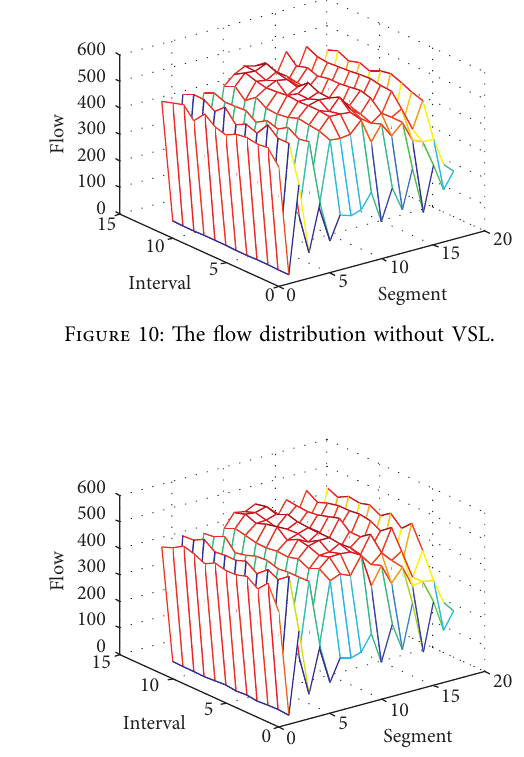
Figure 11: The flow distribution with VSL.